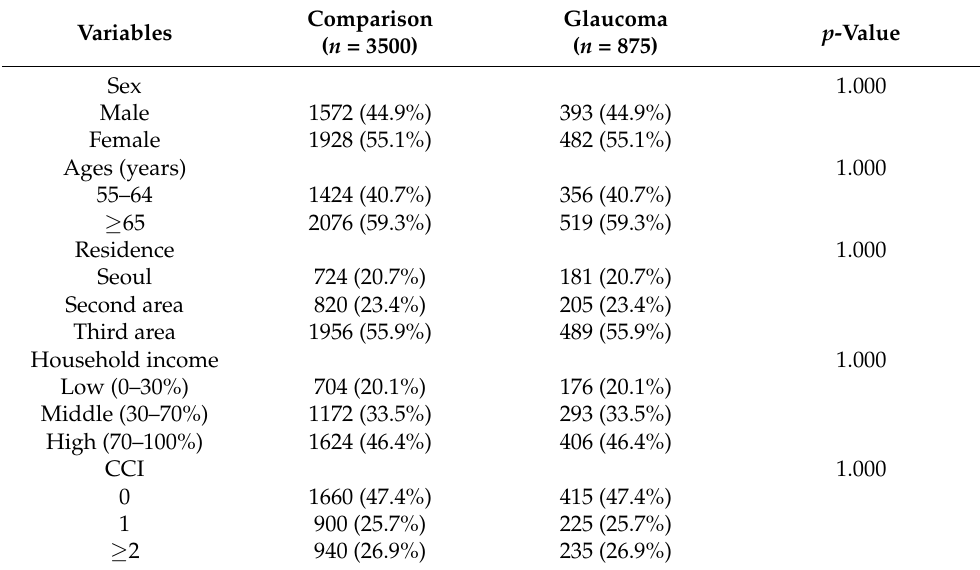
Table 1. Characteristics of the study participants in each group.